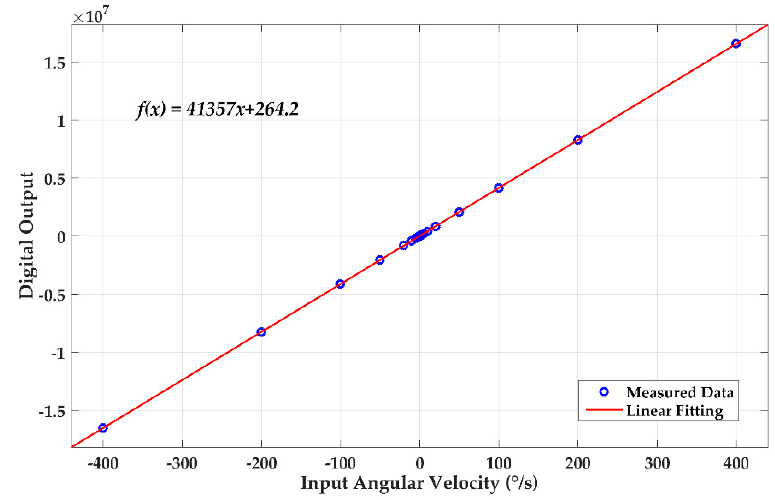
Figure 13. DC transfer function after calibration.